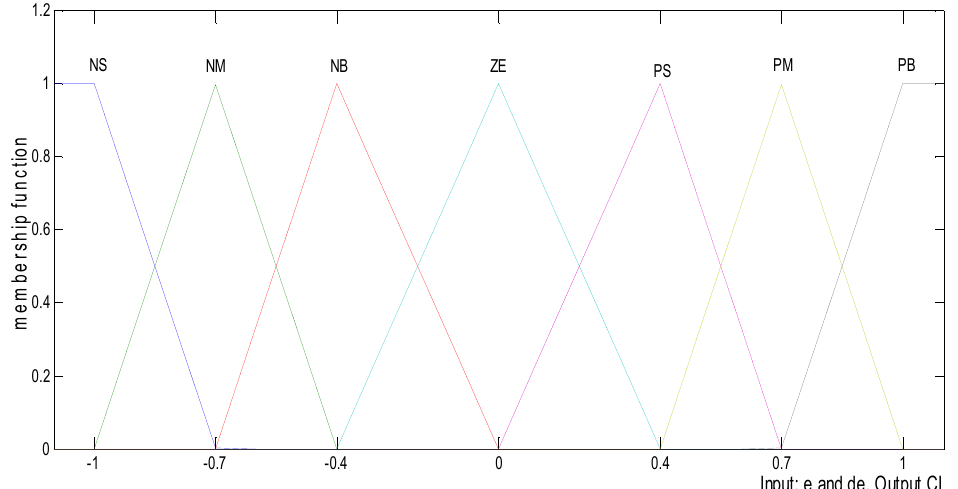
Figure 2. The fuzzification membership function. Table 1. Fuzzy rule-table.